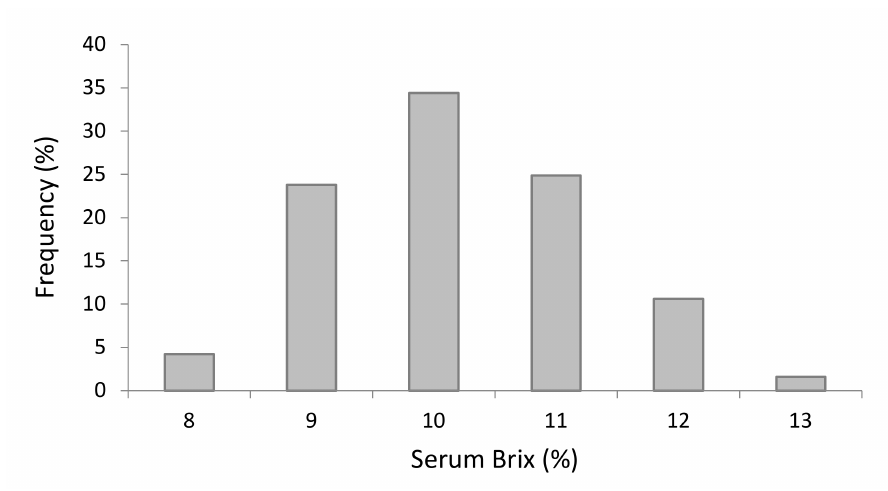
Figure 5. Distribution of Brix% of female Holstein calves’ sera.